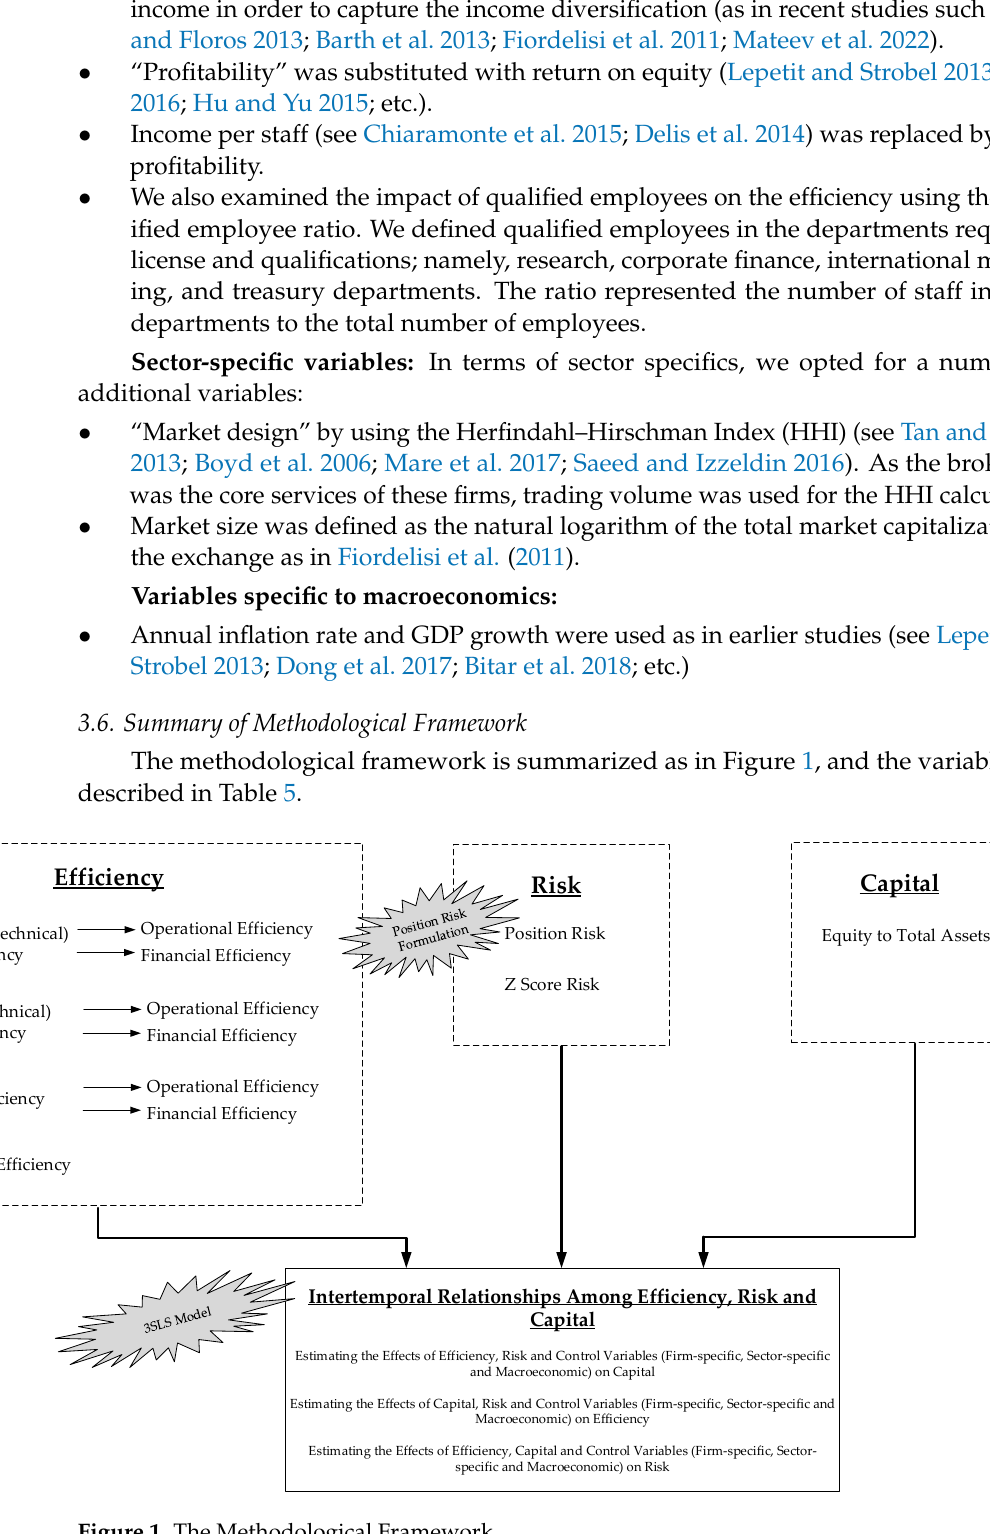
Technical efficiency scores derived from operational data BCC EFF (opr.)